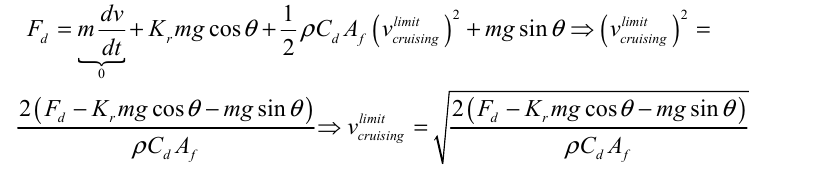
Figure 5. Flowchart of the proposed ACC system. 5.2. Derating Scheme 2: Adaptive Pedal Sensitivity Adjustment (APSA) Peak power transient conditions usually take place during the acceleration of the EV. Therefore, when the estimated 𝑆𝑜𝐹 (cid:3002)(cid:3006)(cid:3023) is relatively low, such transient conditions can subject all system components to safety risks. To resolve this issue, in this section,